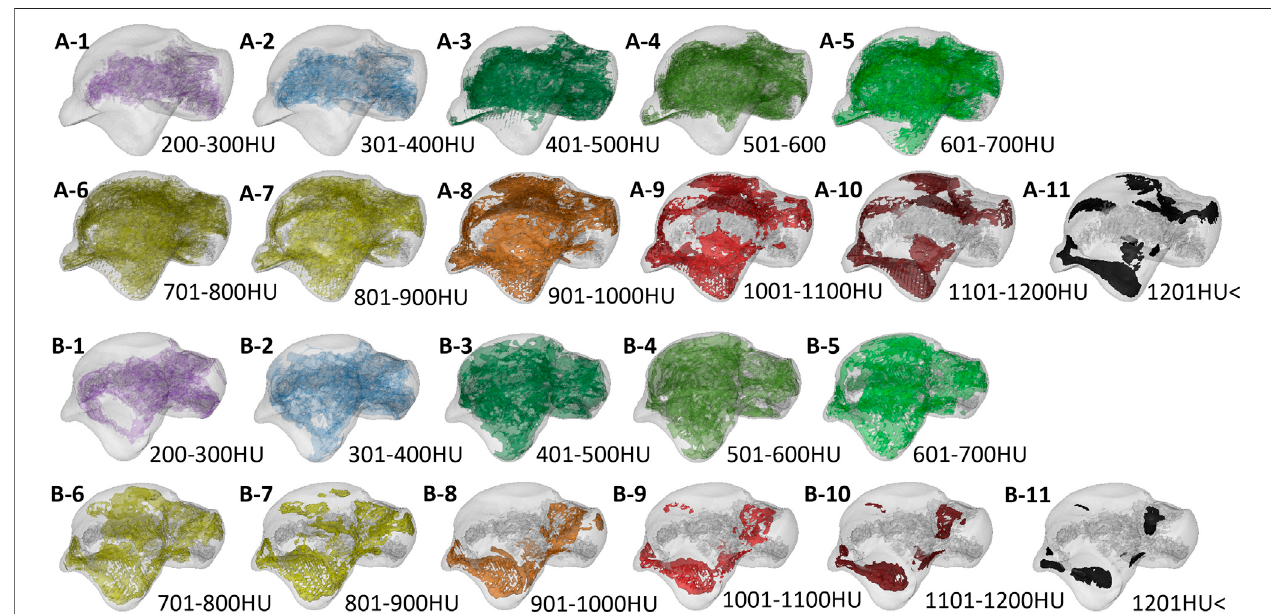
FIGURE8| Thevolume distribution ofbonetissuewithdifferentbonedensitiesinthetalussubchondral boneofthetwogroups. A1 – A11istheTaekwondo group; B1 – B11 is the control group.